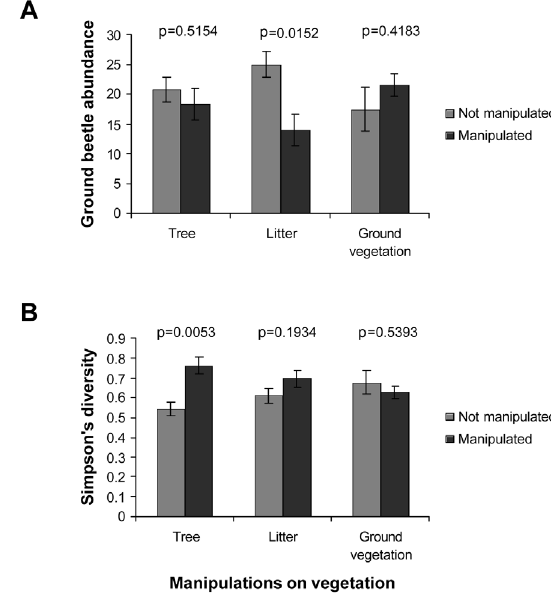
Fig. 3. The effects of disturbance type on ground beetle diversity in experimental plots, p-values are calculated using repeated- measures ANOVA. The error bars show ± 1